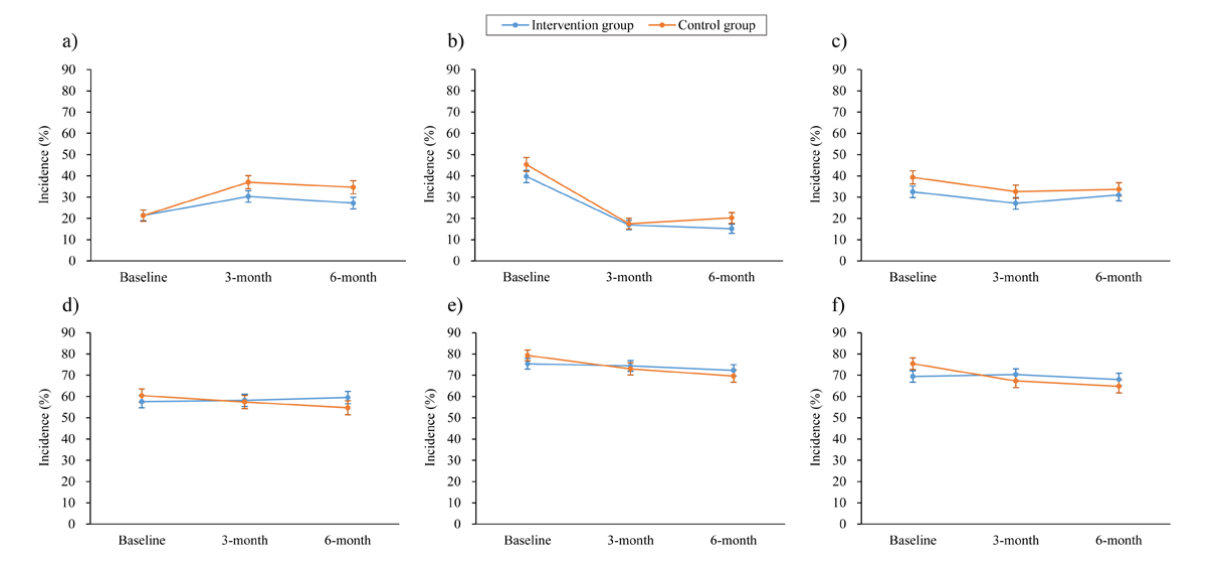
Figure 3. Incidence of caregiver parenting behaviors to prevent unintentional child injury in the past week. a) Giving child a whole or large piece of food that creates a choking risk; b) Placing child in the front seat while riding in a car; c) Letting child ride a bicycle, electric bicycle, or motorcycle unsupervised; d) Testing water temperature before giving child a bath; e) Placing sharp objects where children cannot reach; f) Storing medicines, detergents, and pesticides where children cannot reach. Only those parenting behaviors with significant changes between intervention and control groups are included